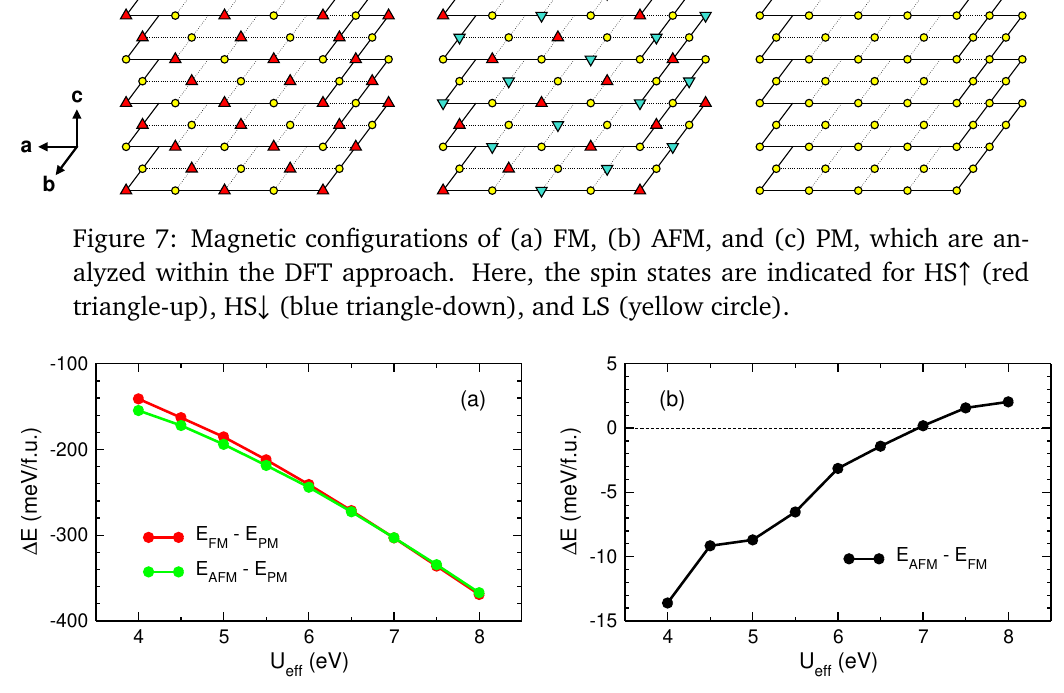
Figure 8: Energy differences as functions of U (green), and (b) E